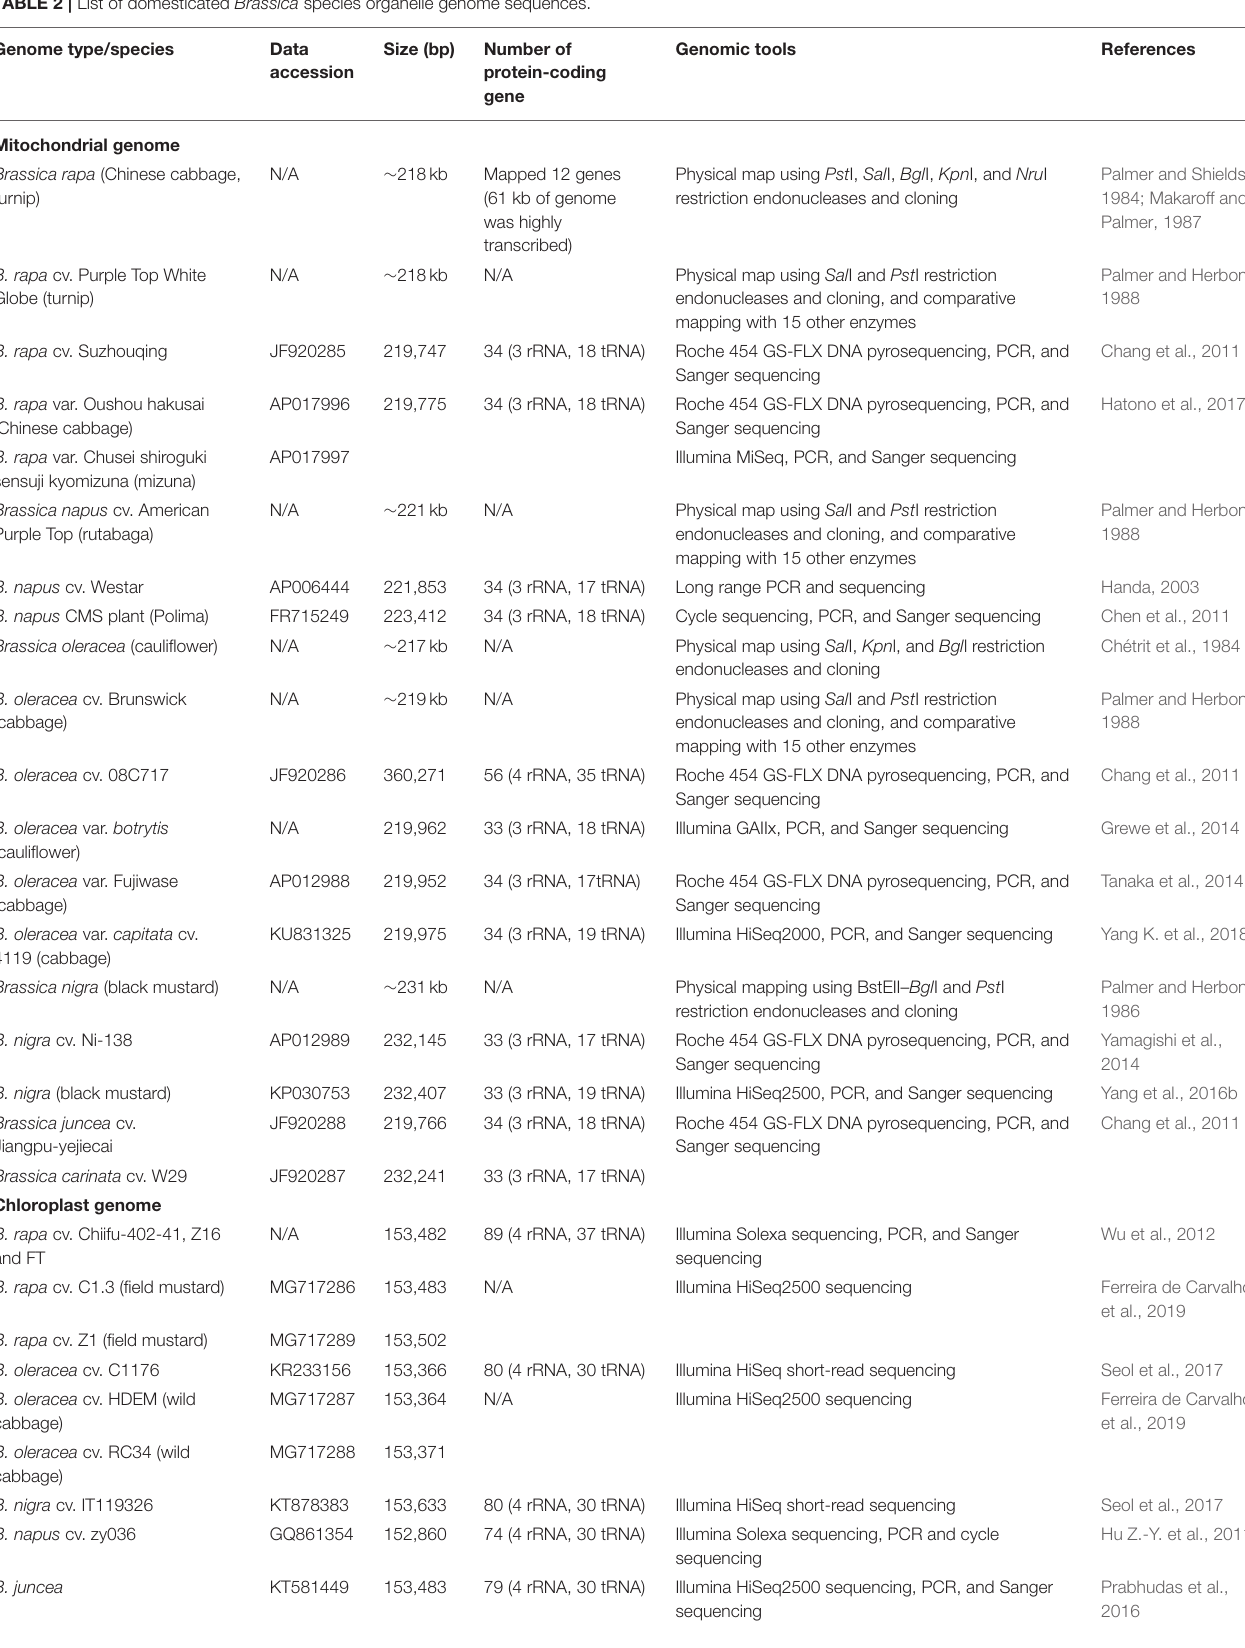
TABLE 2 | List of domesticated Brassica species organelle genome sequences. Genome